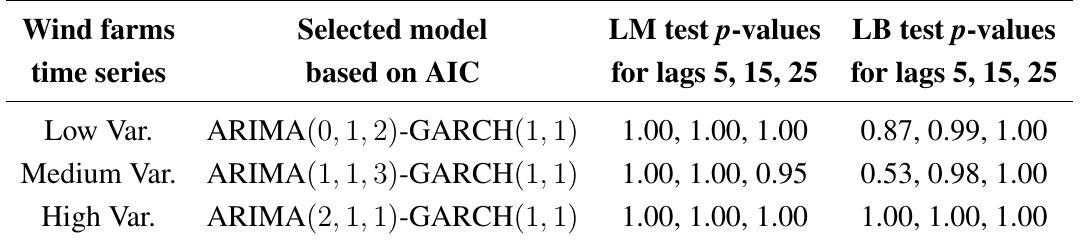
Table 2. Best fitted models for the three wind power time series according to the AIC, with Ljung–Box and LM tests p